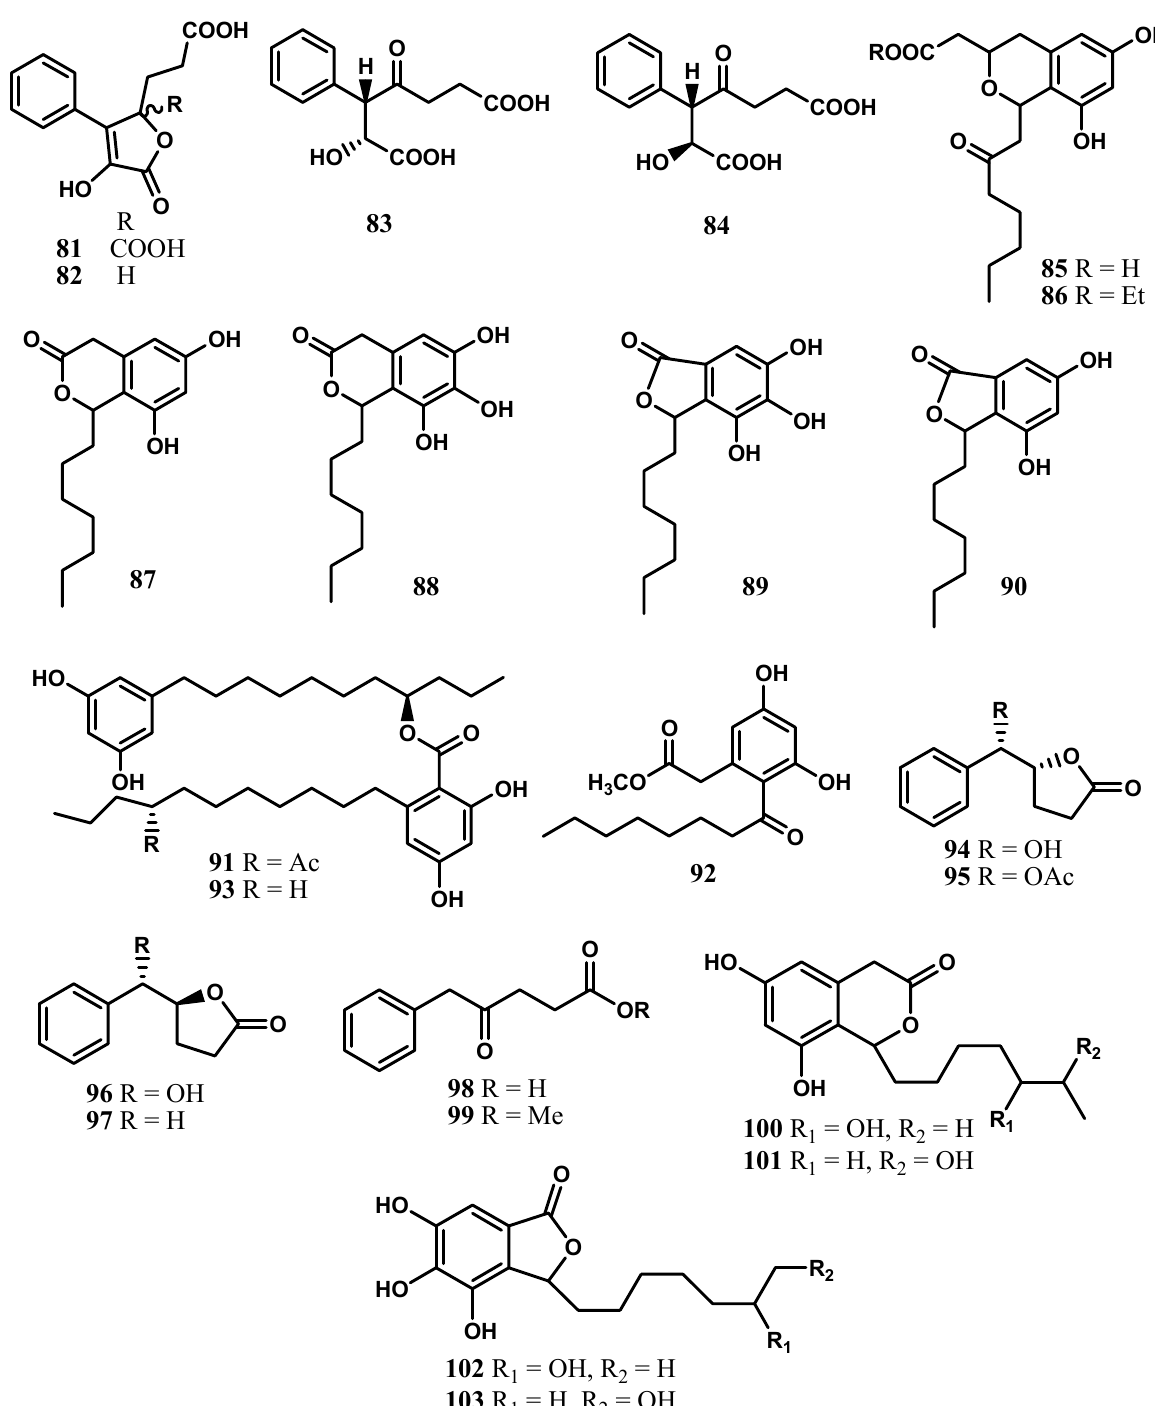
Figure 7. Cytosporones and related compounds from the genus Cytospora.